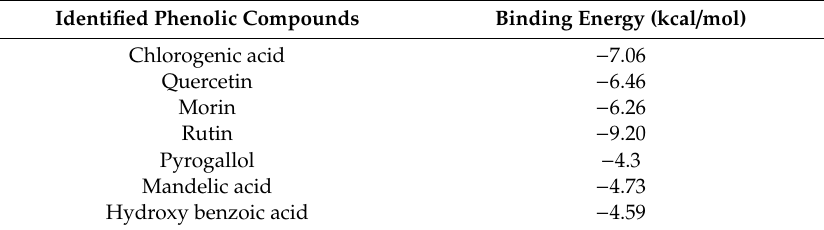
Table 3. Binding energy calculations of the identified phenolic compounds.